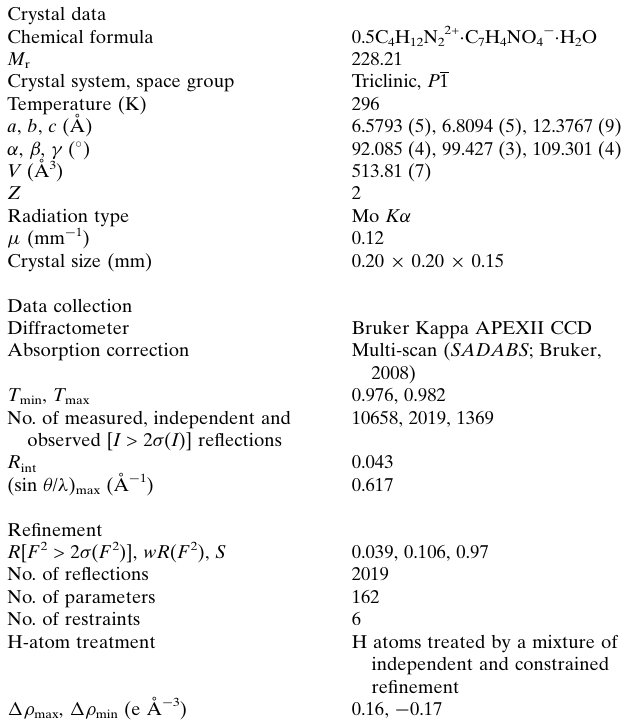
Table 2 Experimental details.